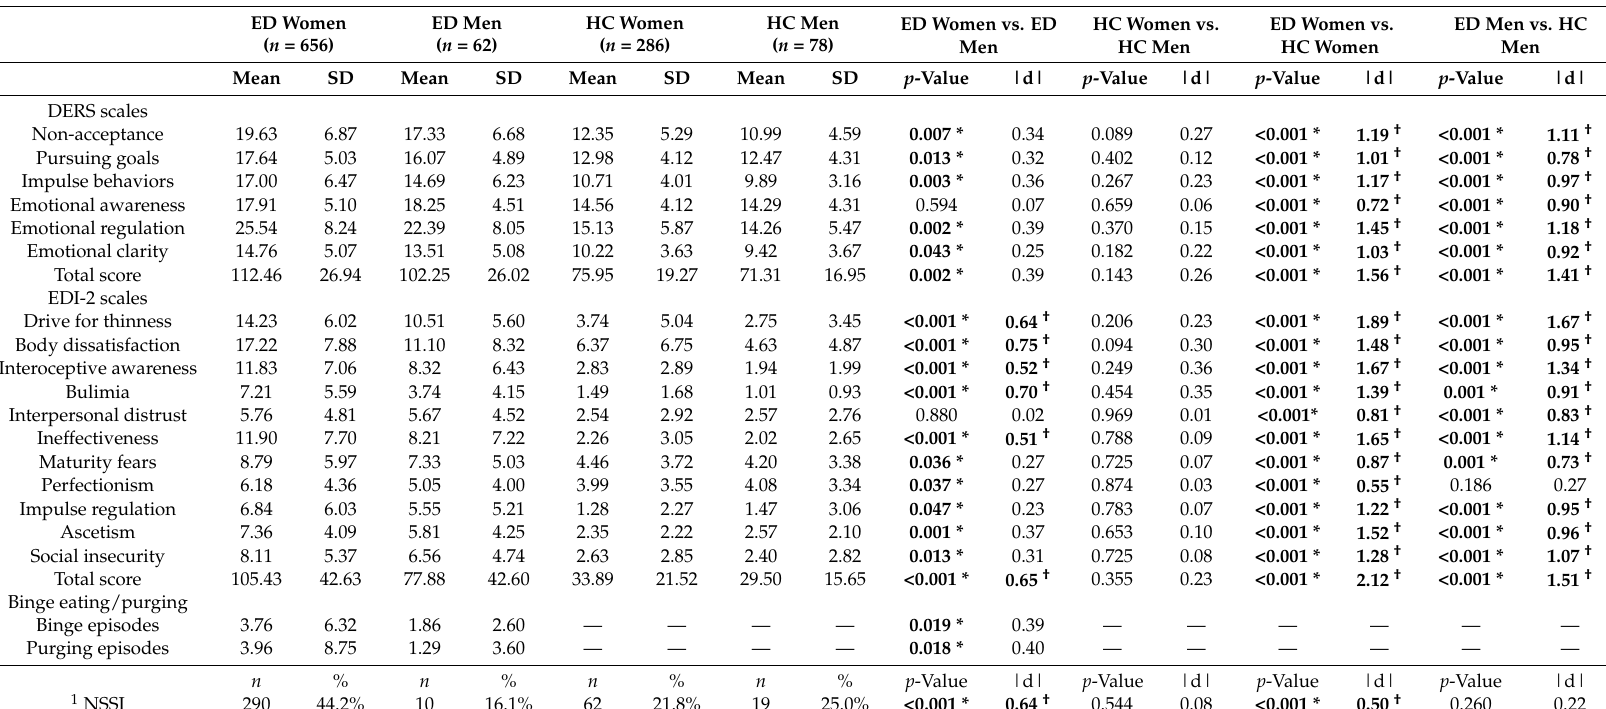
Table 2. Comparison of DERS scales, EDI-2 scales, and negative affect between groups: ANCOVA adjusted for age, civil status, and education.